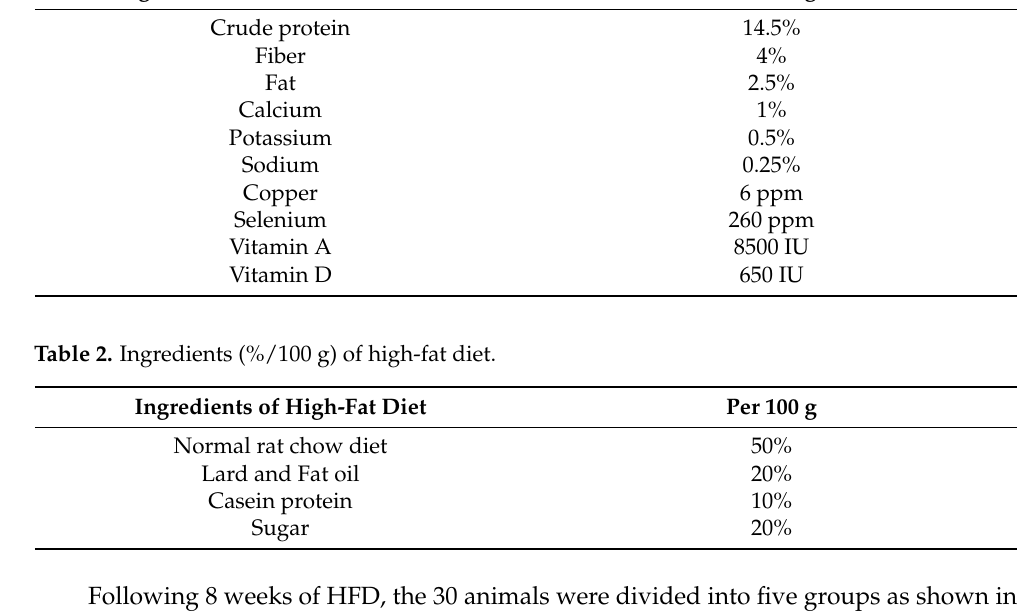
Table 2. Ingredients (%/100 g) of high-fat diet.